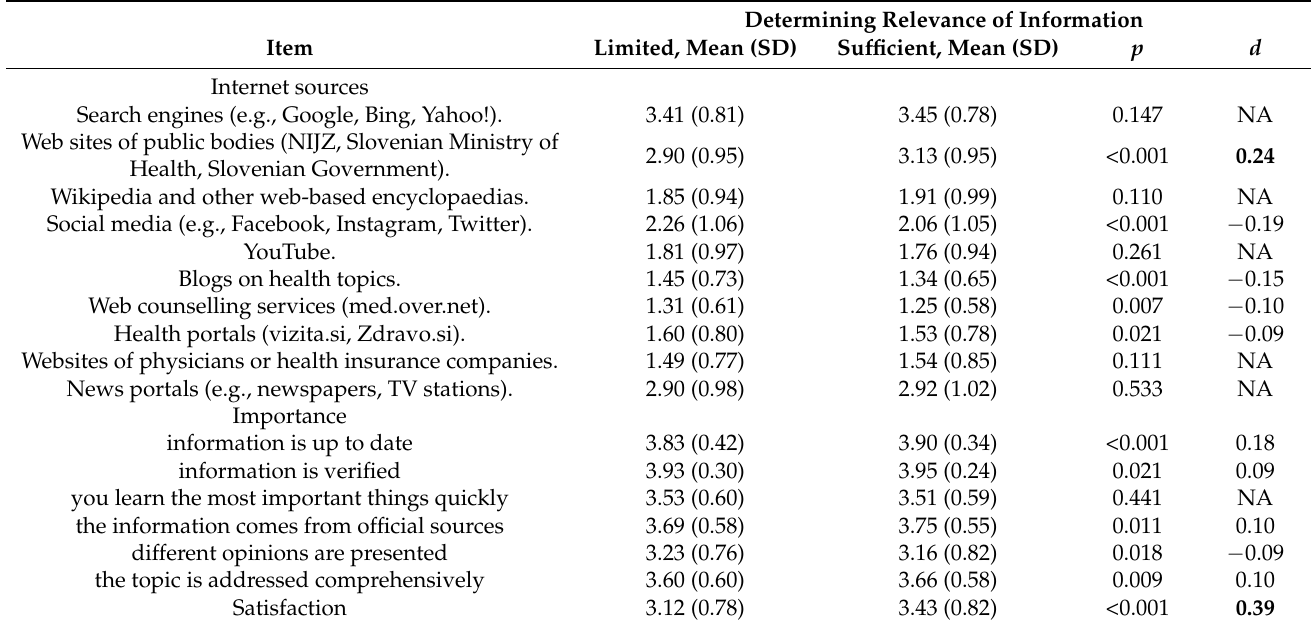
Table 5. DHL regarding the frequency of use of internet sources, perceived importance of individual aspects of the information sought, and information